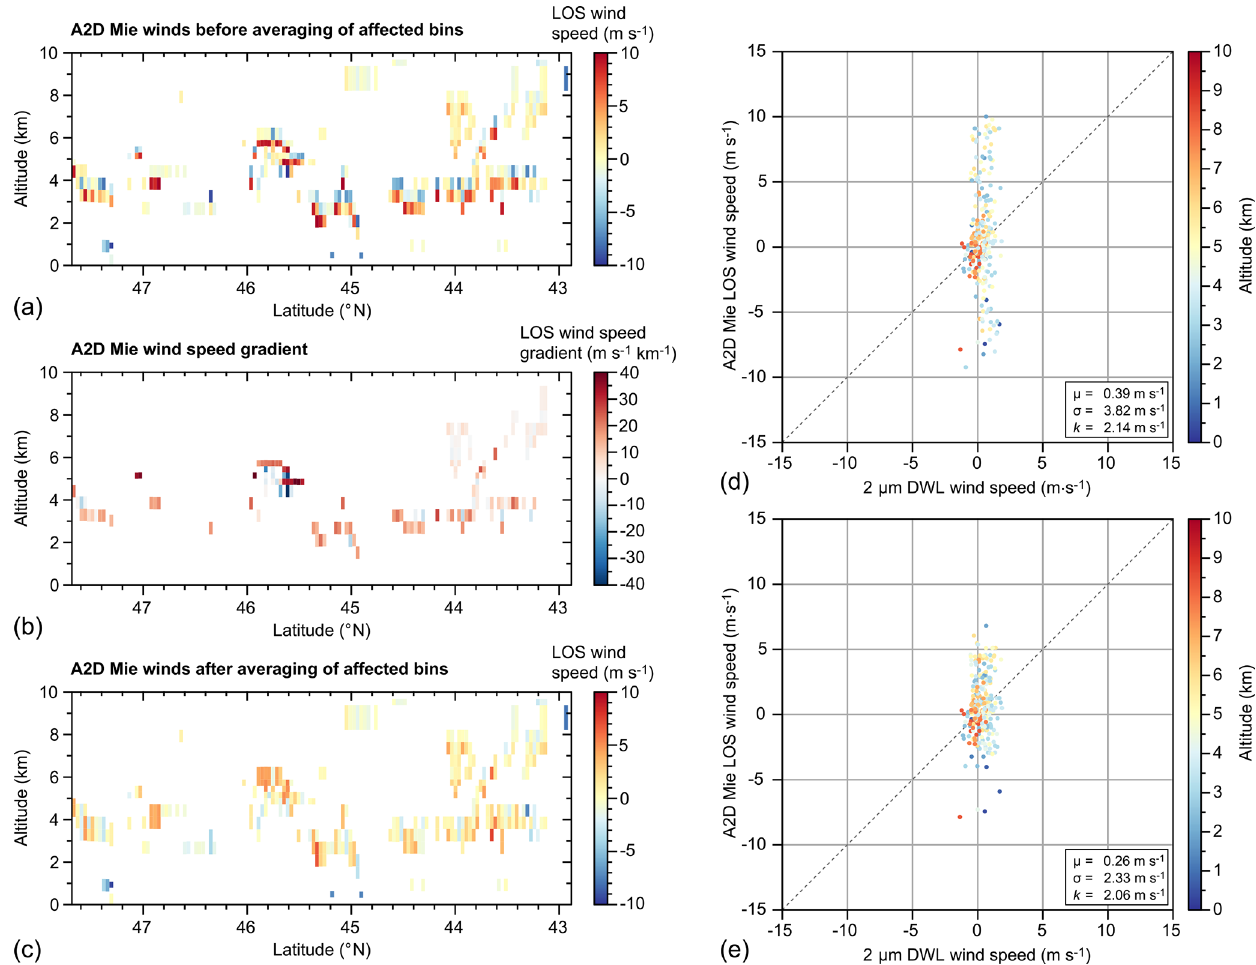
Figure 10. Mie winds for the AVATARE underflight on 23 May 2019 before and after retrieval modifications. (a) A2D Mie winds without bin averaging, (b) Mie wind gradient without bin averaging, and (c) Mie winds with bin averaging. The right scatterplots show the correlation between the Mie winds and the 2µm DWL wind data without (d) and with (e) bin